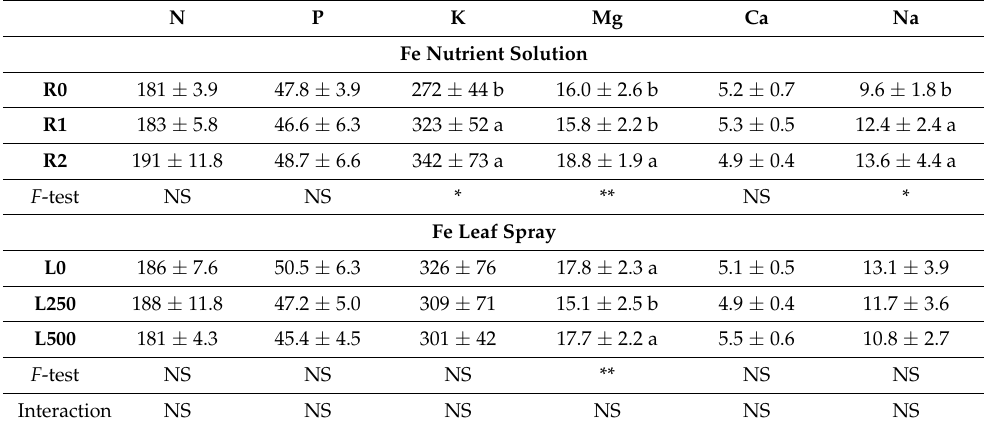
Table 4. Effects of Fe application on the macronutrient composition (mg 100 g − 1 FW) of fruits from the 2nd cluster of cherry tomato plants.